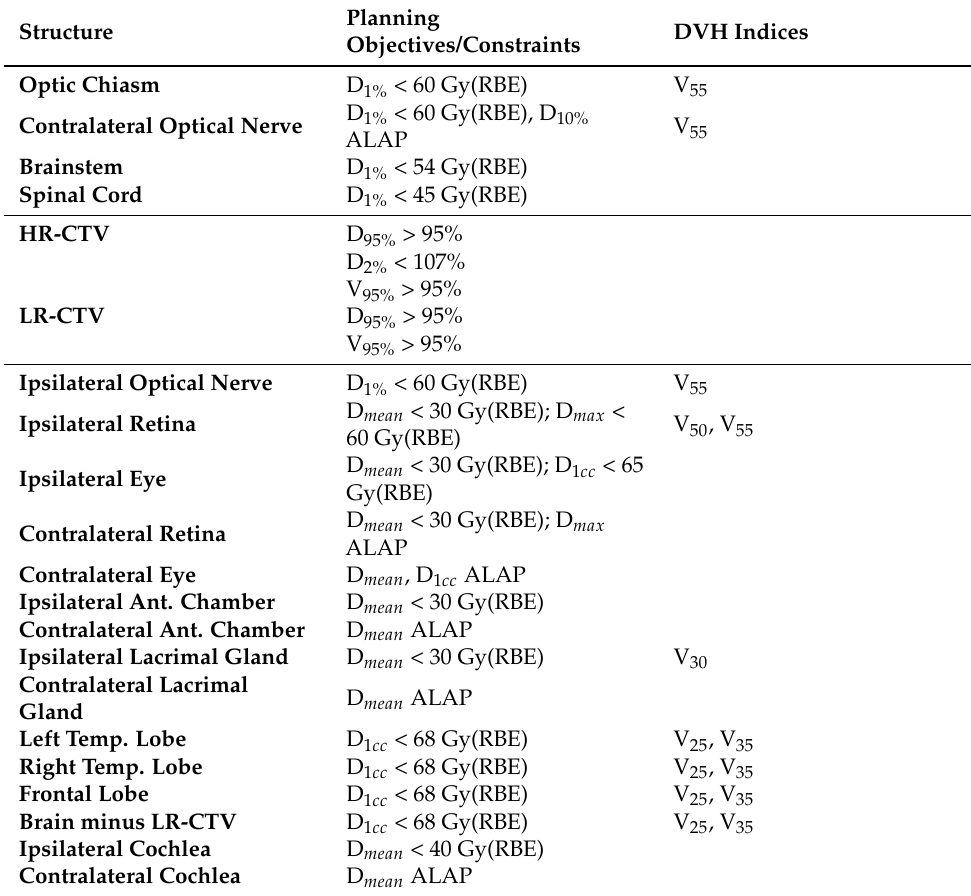
Table 1. Dose planning goals are grouped in descending order of priority in column 2. D x is the dose covering the x% of the structure volume while V x is the volume of structure receiving x Gy(RBE). D mean and D max are the mean and the maximum dose, respectively. DVH parameters included in the study for plan comparison are listed in column 3. ALAP = As Low As